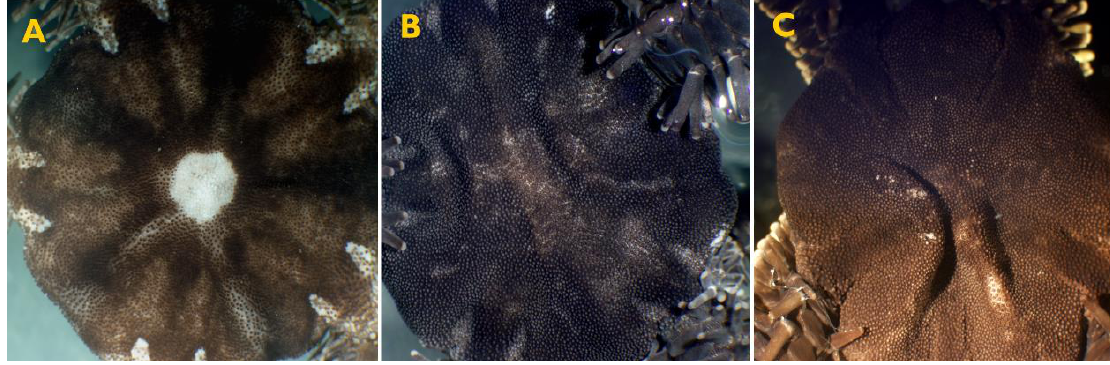
F IGURE 5. Dorsal disc color variation of Ophiocoma scolopendrina from A. Dayyer Port, B. Nayband Bay, and C. Qeshm Island